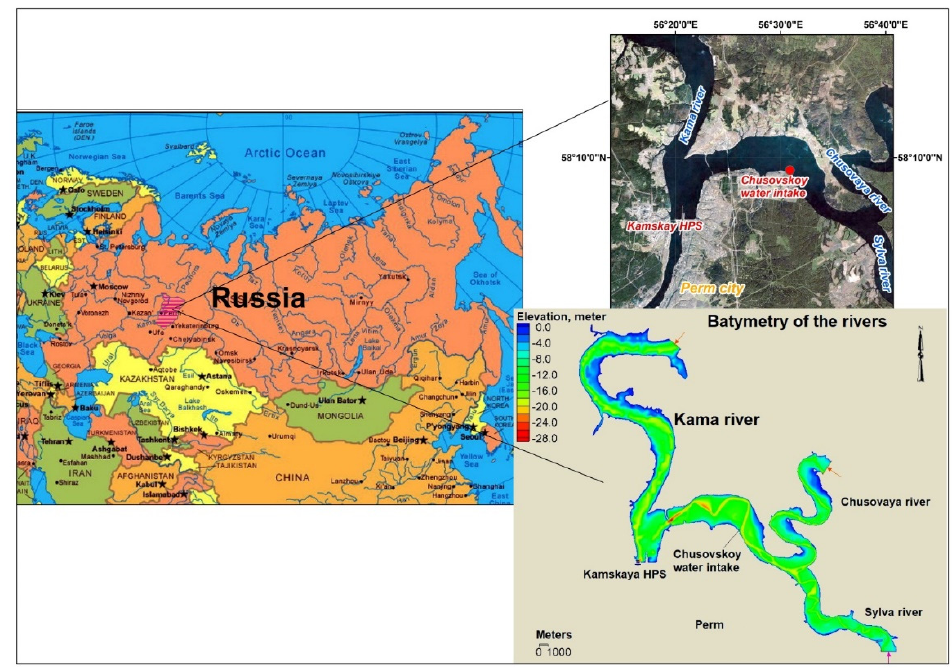
Figure 1. Study area location.